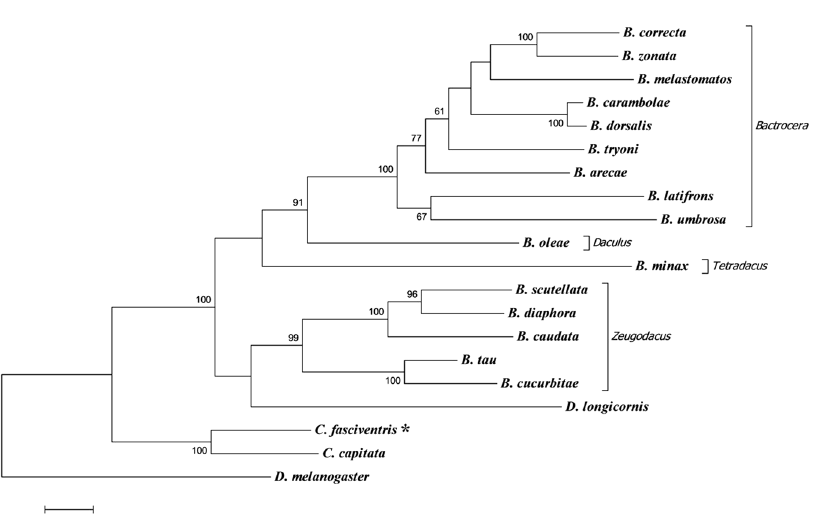
Figure 7. Molecular phylogenetic analysis by Maximum Likelihood method. Tree based on 13 protein coding genes from complete mitochondrial genome sequences of 19 Tephritidae species. The tree is drawn to scale, with branch lengths measured in the number of substitutions per site. Asterisk indicates the Ceratitis fasciventris sequence analyzed in the present study. Clustering based upon subgenera for the Bactrocera genus is indicated by bars along the right hand side of the phylogenetic tree. Drosophila melanogaster was used as out group to root the tree. Numbers at nodes are for bootstrap percentages from 1000 replicates; only the ones higher than 50 are presented. The GenBank accession numbers of the mtDNA sequences used are given in Supplementary Table